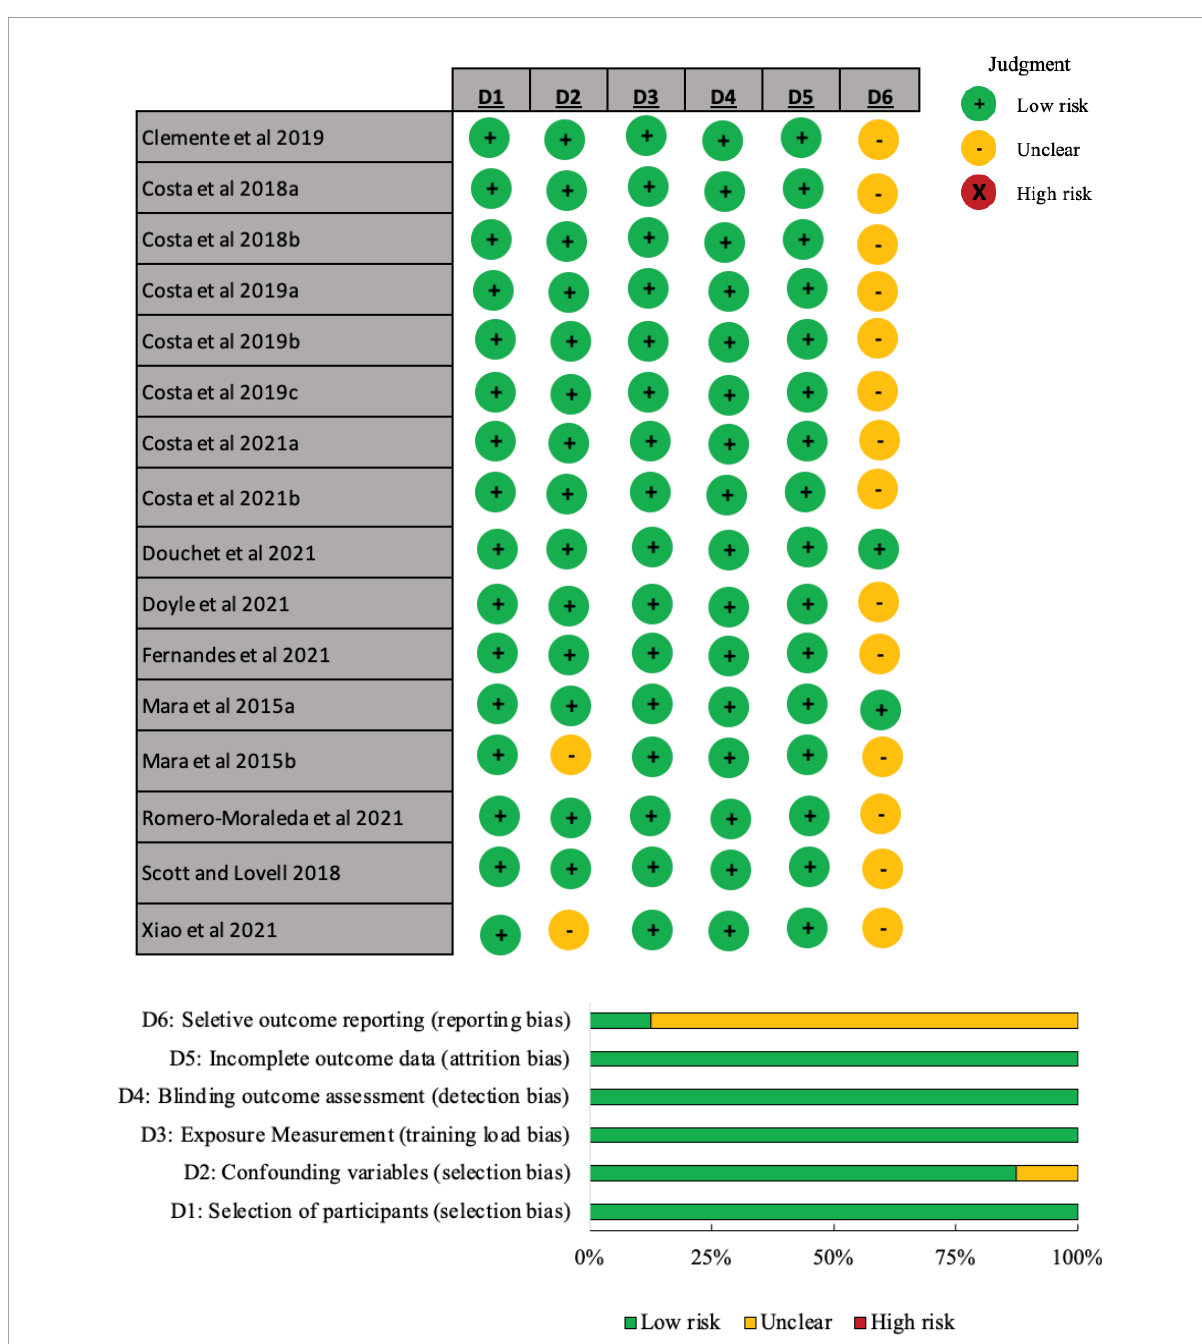
FIGURE2 Risk of bias judgments for training load monitoring in highly trained and elite adult women’s soccer studies through RoBANS.